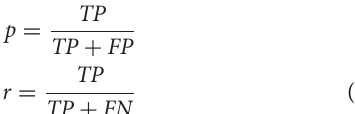
in Table 4 : true positive (TP), false positive (FP), false negative (FN), and true negative (TN). The precision ratio ( p ) and